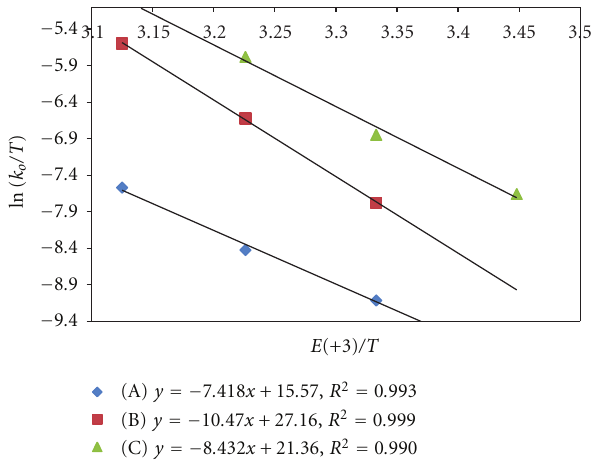
Figure 4: Eyring’s plot of ln( k o /T ) versus 1 /T for Ru (III) catalyzed reaction. Reaction (A) Acetone (B) EMK (C) IBMK.